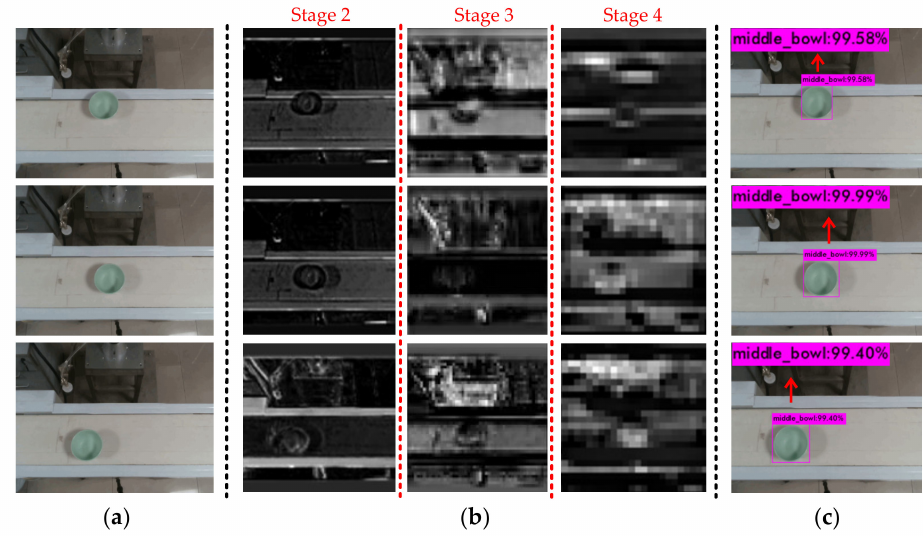
Figure 10. YOLOv4 detect result: ( a ) Input images; ( b ) Feature extraction maps; ( c ) Output